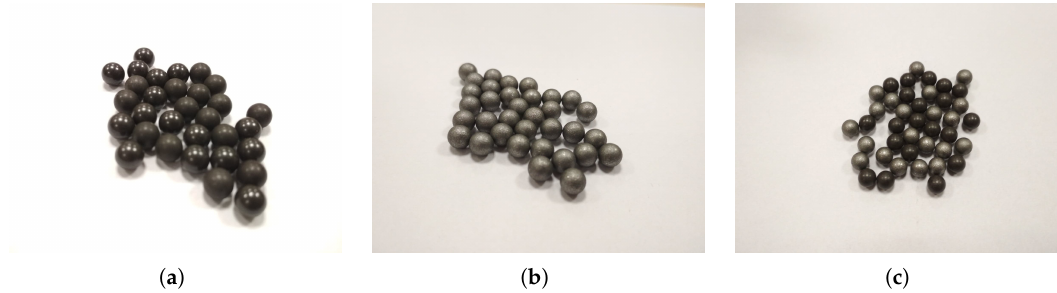
Figure 3. The investigated grains. ( a ) Plastic particles; ( b ) Steel particles; ( c ) Mixed particles.